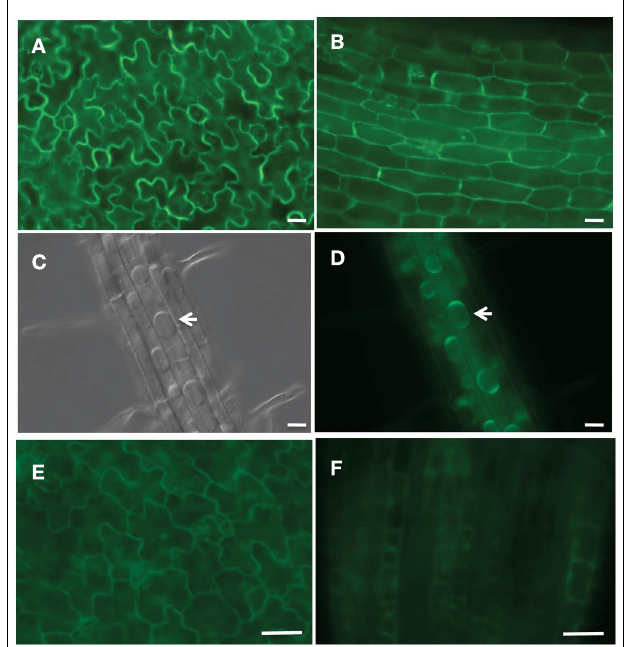
FIGURE 7 | Subcellular localization of GFP-tagged MIOX in Arabidopsis seedlings. GFP-tagged MIOX2 and 4 were expressed in miox2-2 andWT backgrounds, respectively, and imaged with fluorescent deconvolution microscopy. MIOX2:GFP/ miox2-2 seedling expression in (A) cotyledon epidermis, (B) hypocotyl, (C,D) plasmolyzed roots treated with 0.8M NaCl; arrows denote plasmolyed cells. (C) Was taken with DIC optics. MIOX4:GFP expression in (E) cotyledon epidermis and (F) root tips. Bar = 20 μ